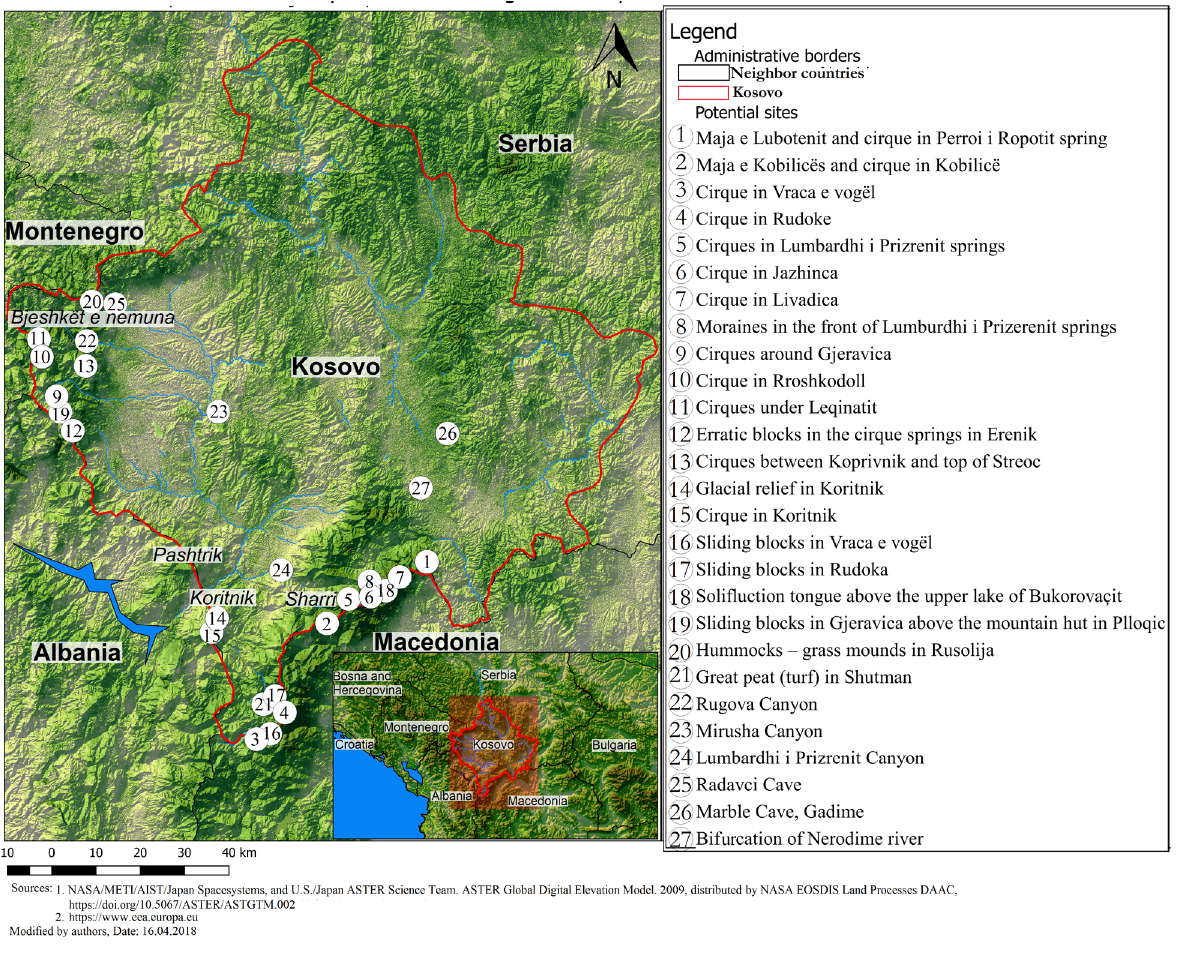
Figure 1: Regional and international geomorphological natural heritage values of